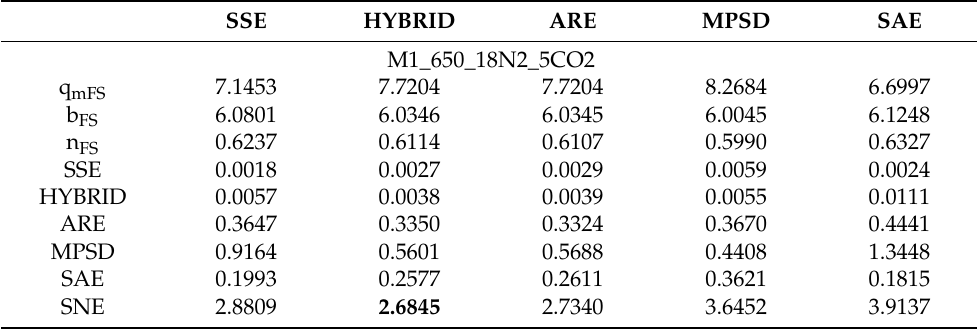
Table 8. Fritz-Schlunder isotherms constants with error analysis